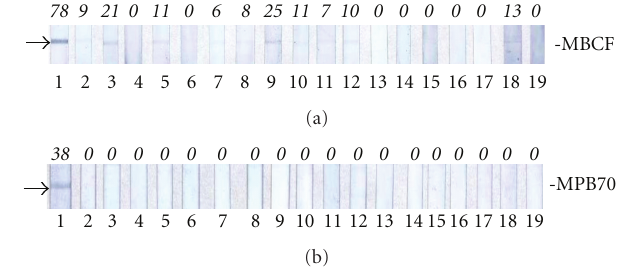
Figure 2: IgG (a) and IgM (b) antibody responses of the horse infected with M. tuberculosis. MAPIA was performed as described in the Materials and Methods Section. Strip images represent individual results obtained with serum samples from the infected horse (no. 1), and 18 presumed non-infected horses from the same farm (nos. 2–19). Arrows point at the bands indicating antibody reactivity found in the infected horse. Printed antigens are shown on the right. Figures in italic above the strips indicate MAPIA densitometry values (in arbitrary units) obtained for respective serum